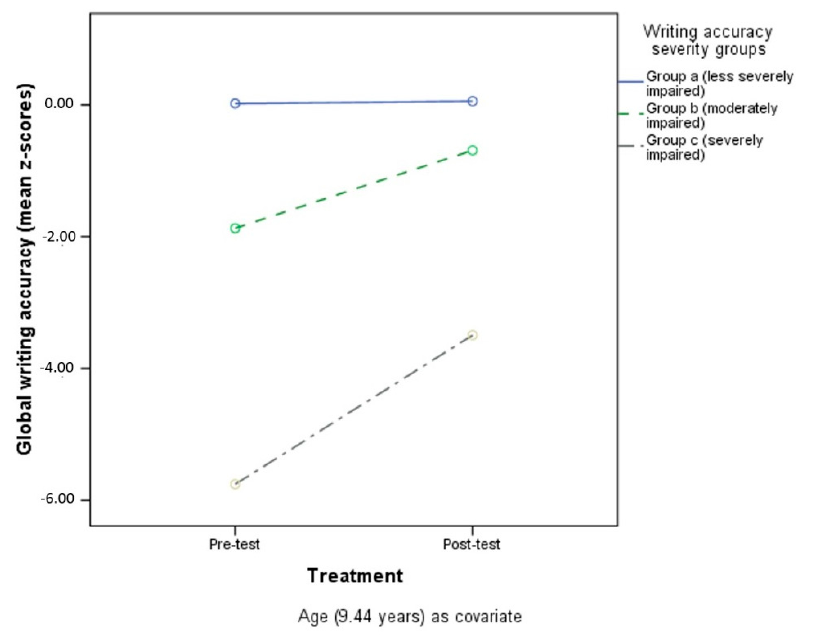
Figure 3. Pre- and post-test writing accuracy in the three different impairment severity groups. Setting age as a covariate in the same repeated measures ANOVAs did not change the results (treatment x severity: all p <